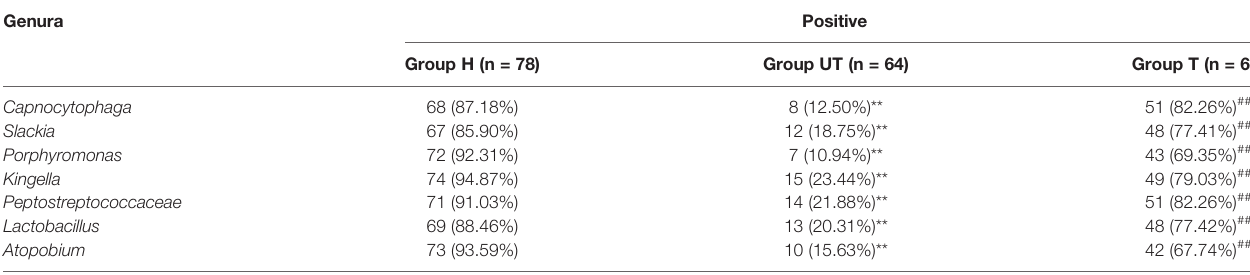
TABLE 5 | Different genera of bacteria in saliva samples of AIDS patients after HAART treatment.